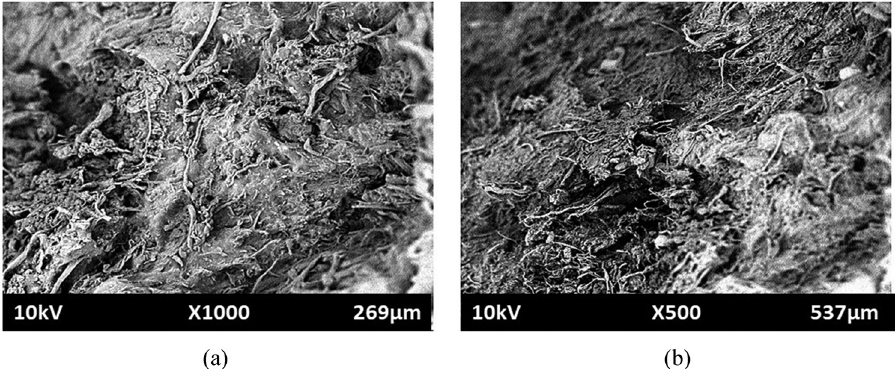
Figure 33: SEM tensile - fractured micrographs of leather bu ffi ng dust/recycled EVA polymer composites at a magni fi cation of ( a ) 1,000 × ; ( b ) 500 ×